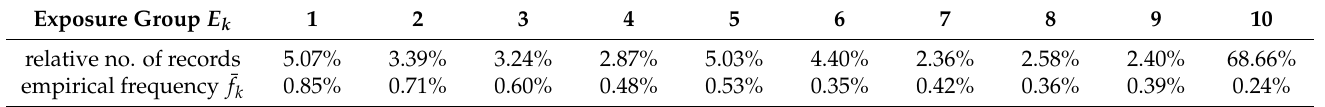
Table 3. Relative number of records and empirical frequency for each exposure group.